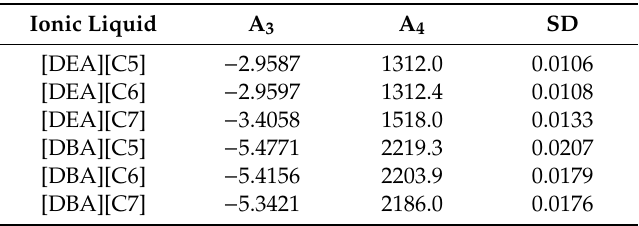
Table 3. Fitting parameters of Equation (2) to correlate viscosity ( η ) of PILs and calculated standard deviation